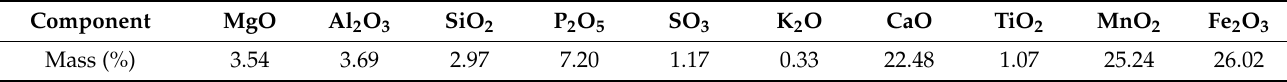
Table 1. Mineralogical analysis of the manganese